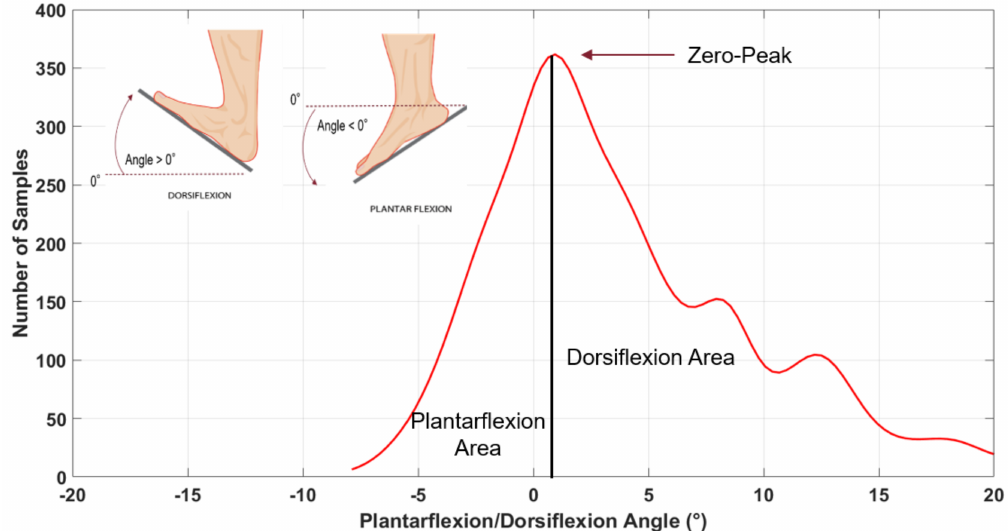
Figure 2. Fit curve divided into Plantarflexion Area (left of the solid vertical line) and Dorsiflexion Area (right of the solid vertical